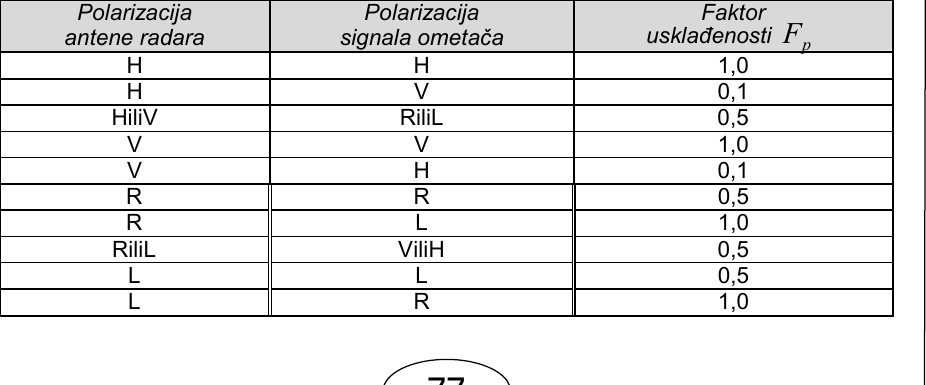
. U tabelama 4, 5 i 6 prikazane su karakteristike ometa č a koji se koriste za ome- tanje iz zone, eskortno ometanje i samozaštitno ometanje respektivno. Tabela 3 Koeficijent uskla đ enosti polarizacija signala radara i ometa č a Polarizacija Polarizacija Faktor uskla đ antene radara signala ometa č a